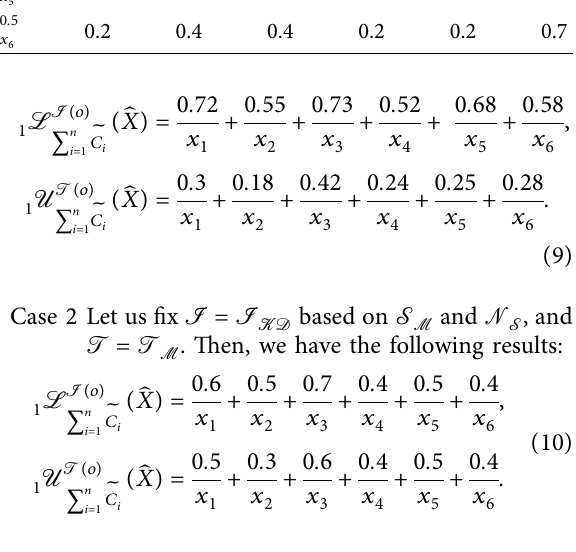
Table 2: Table for 􏽥 C